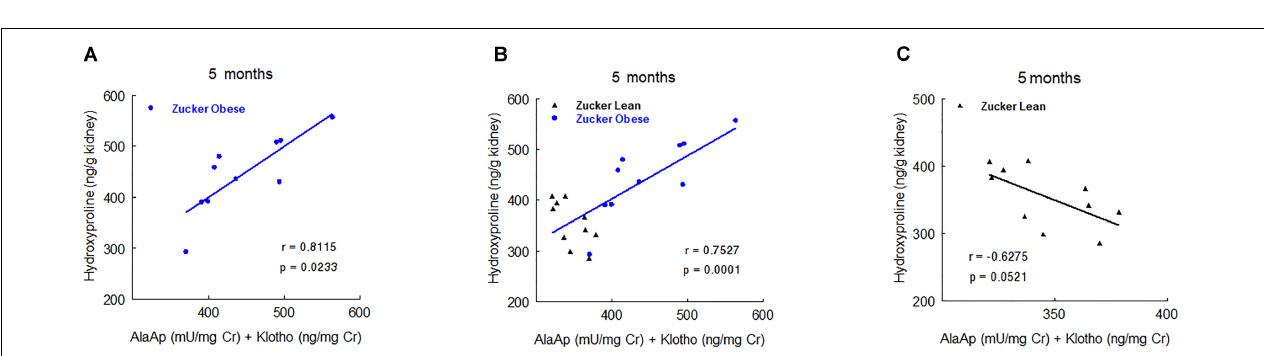
FIGURE 6 | Predictive correlations of urinary GluAp activity at 2 months old with interstitial fibrosis at the end of the experiment in ZO rats ( A , n = 10), in ZL and ZO rats ( B , n = 20) and in ZL rats ( C , n = 10).